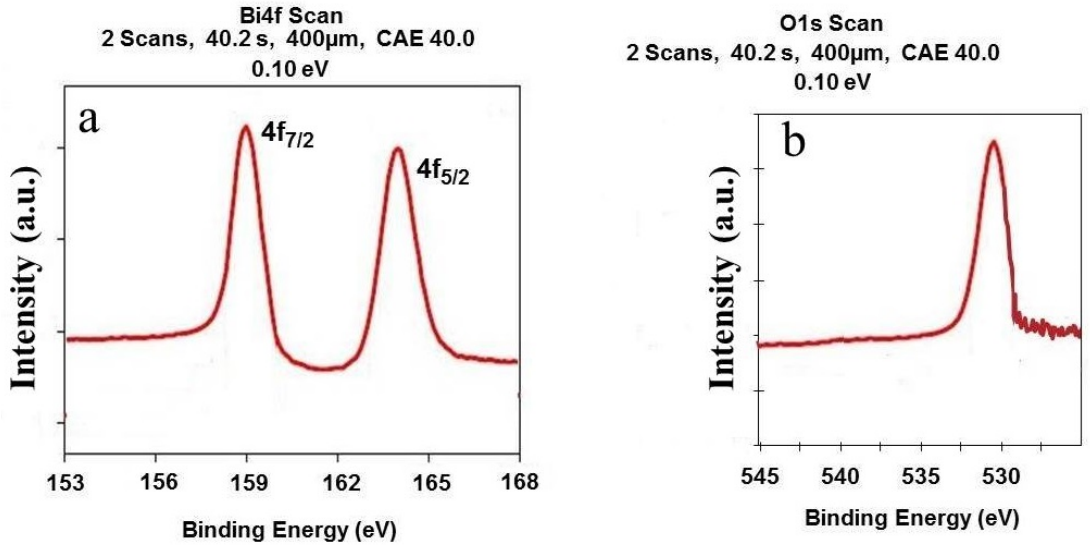
Figure 12. XPS spectra of Bi 2 O 3 nanorods ( a ) Bi and ( b ) O obtained by thermolysis of compound 1.